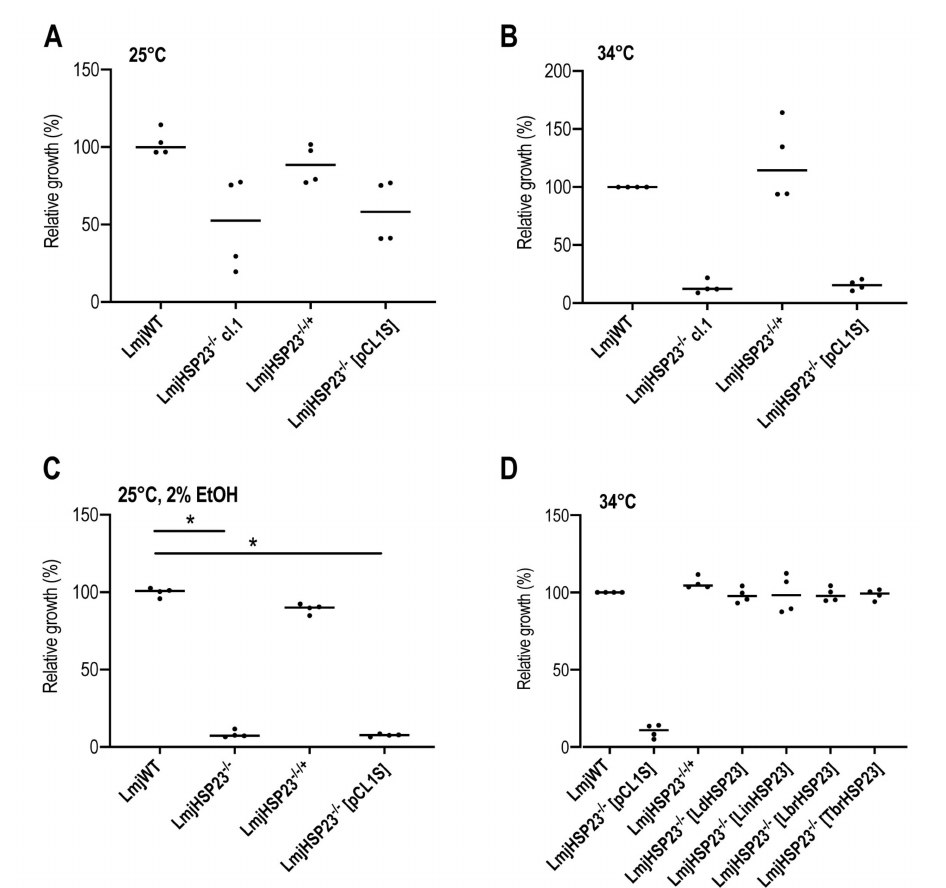
Figure 5. Phenotypic analysis of L. major HSP23 – / – mutants and complementation strains. 1 × 10 6 or 5 × 10 6 parasites / ml were seeded in 10 ml complete M199 medium and parasite density was assessed at day 4. Parasites were grown at 25 ◦ C ( A ), 34 ◦ C ( B ), and 25 ◦ C with 2% EtOH ( C ). Cell density is shown as percentage of WT (set at 100%). ( D ) Complementation studies in LmjHSP23 – / – mutants. Null mutants were transfected with the pCL1S over expression vector harbouring the HSP23 gene of L. major, L. donovani, L. infantum, L. braziliensis , and Trypanosoma brucei or with the empty vector only. Complementation populations were subjected to growth experiments at 34 ◦ C. Cell density was assessed at day 4 and is shown normalised to Lmj WT growth (set at 100%). * = p <